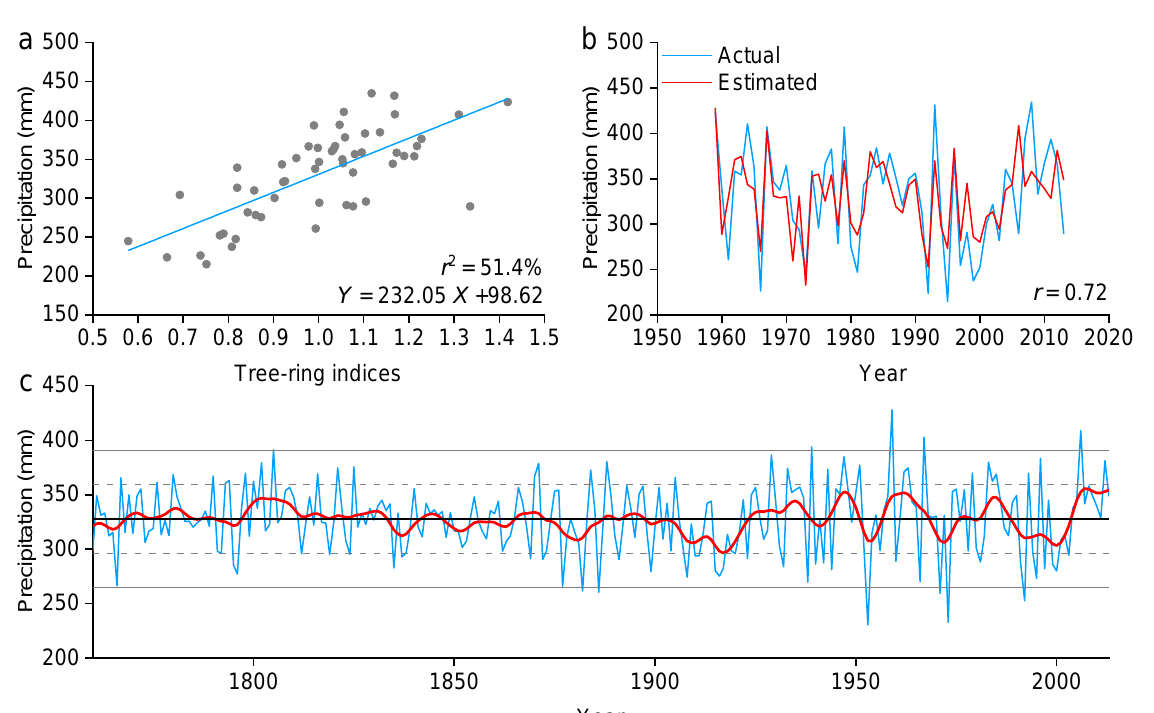
Figure 5. ( a ) Scatter plot of August–June total precipitation and tree-ring residual chronology with a linear fitting curve (1958–2013). ( b ) Comparison between actual and reconstructed precipitation during the common period 1958–2013. ( c ) Reconstructed total previous August-June precipitation (blue line) and 31-year smoothing (red line). The inner horizontal (dotted) lines indicate the border of one standard deviation, and outer horizontal lines indicate two standard deviations.